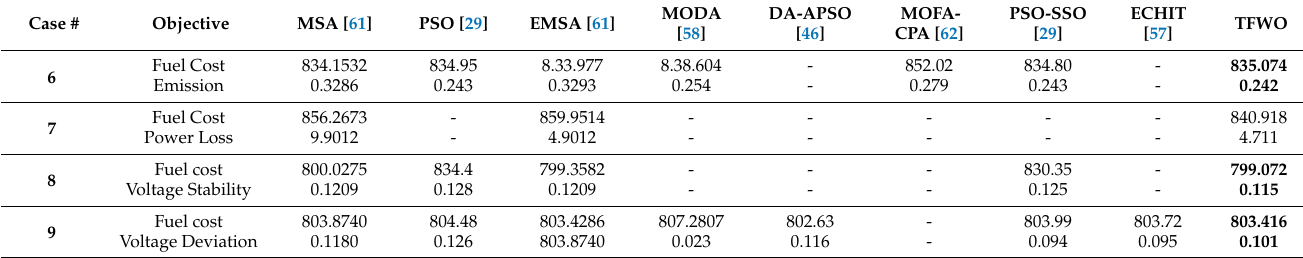
Table 5. TFWO versus recent optimization algorithms from the literature for multi-objective functions for (Cases